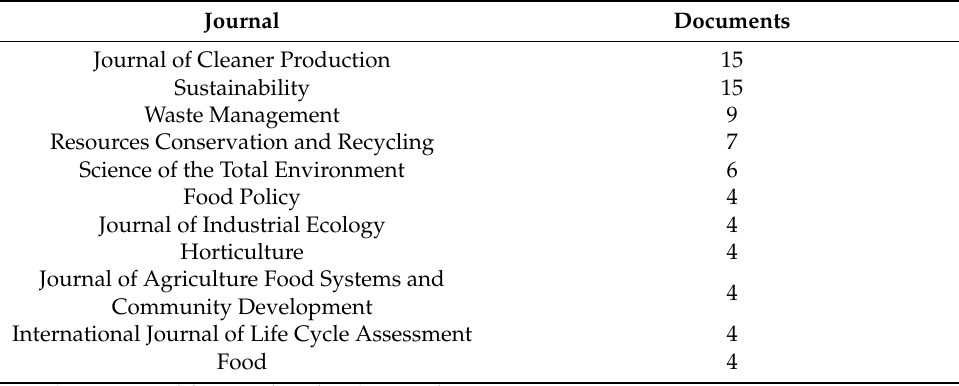
Table 1. Number of documents ordered by